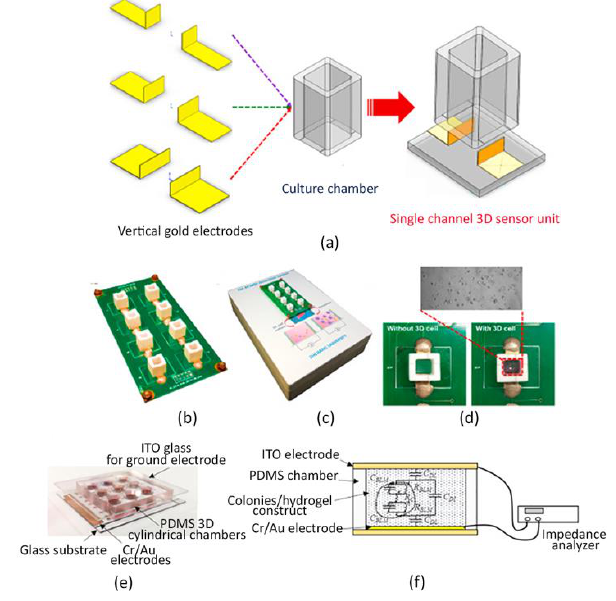
Figure 4. Impedance sensors. ( a ) Scheme of the 3D impedance biosensor single-unit composed of two vertical gold electrodes assembled with the PET culture chamber and the glass substrate. ( b ) Eight-channel 3D impedance biosensor. ( c ) 3D electric cell/matrigel-substrate detection platform containing the 3D impedance biosensor, a signal-conditioning module and a computer-controlled data acquisition card. ( d ) Illustration of the 3D single impedance biosensor before (left) and after (right) culturing HepG2 embedded in Matrigel hydrogel. ( e ) Image of the multi-layer impedance sensor consisting of an indium tin oxide (ITO) glass slide for the ground electrode, a PDMS layer composed of nine independent 3D cylindrical chambers able to host 3D cell-laden hydrogels, and a glass substrate provided with nine Cr/Au electrodes. ( f ) Illustrative design of the experimental set-up and the equivalent circuit to monitor impedance in cancer colonies within 3D hydrogels between the parallel plate electrodes. ( a – d ) Reprinted from [188], Copyright (2019), with permission from Elsevier; ( e , f ) Reprinted from [190], Copyright (2015), with permission from